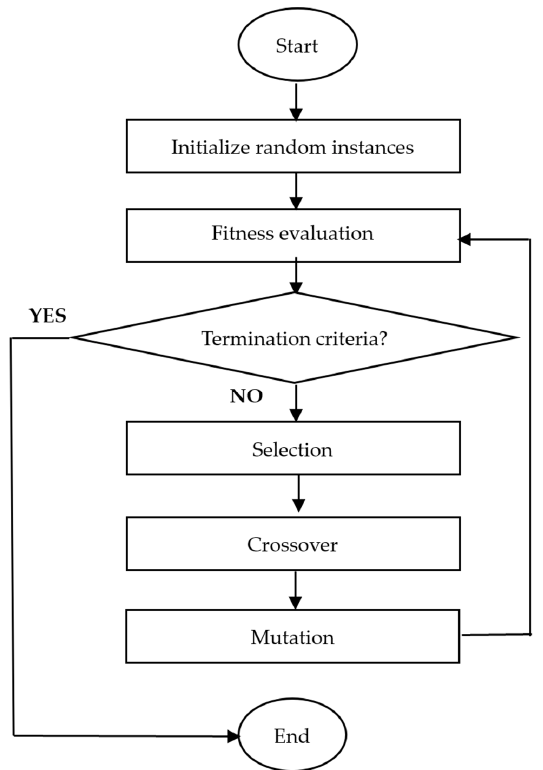
Figure 2. Flowchart of principal steps in the GA